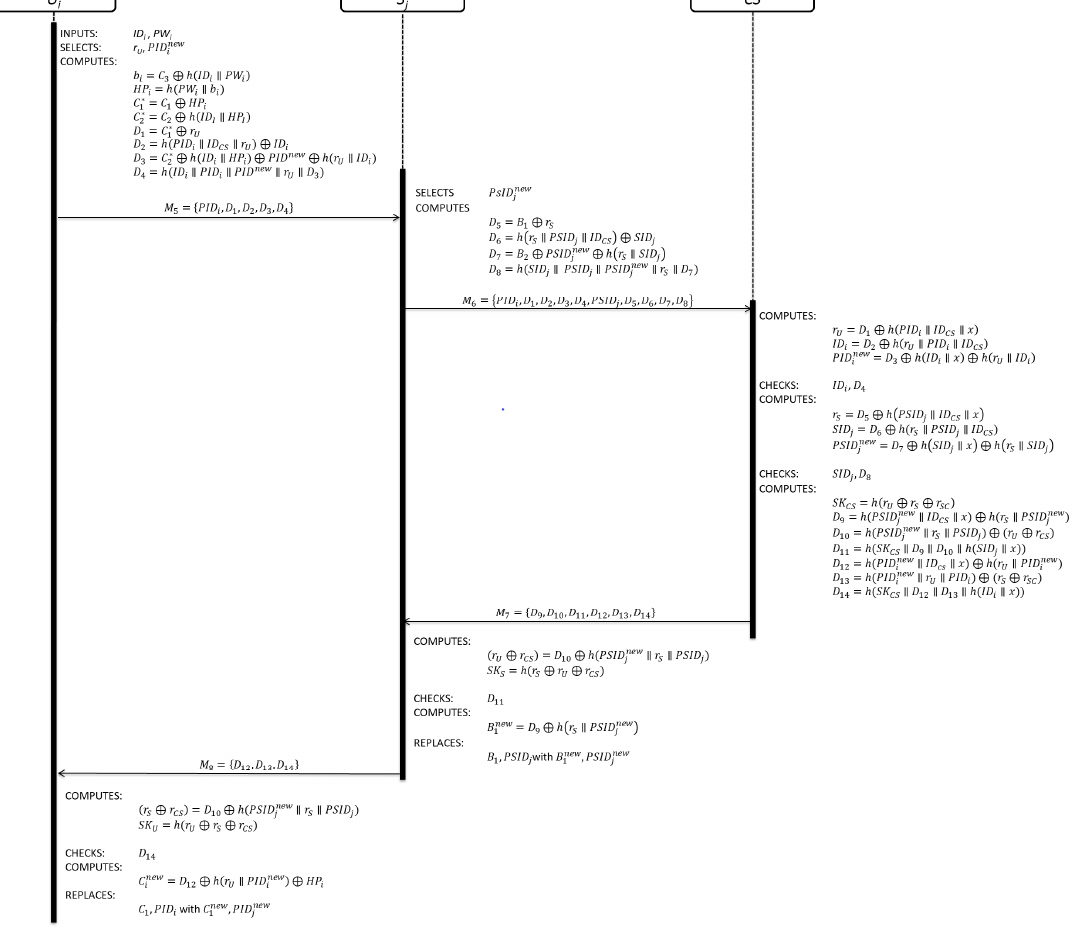
Figure 1. Authentication phase of Zhou et al.’s scheme.